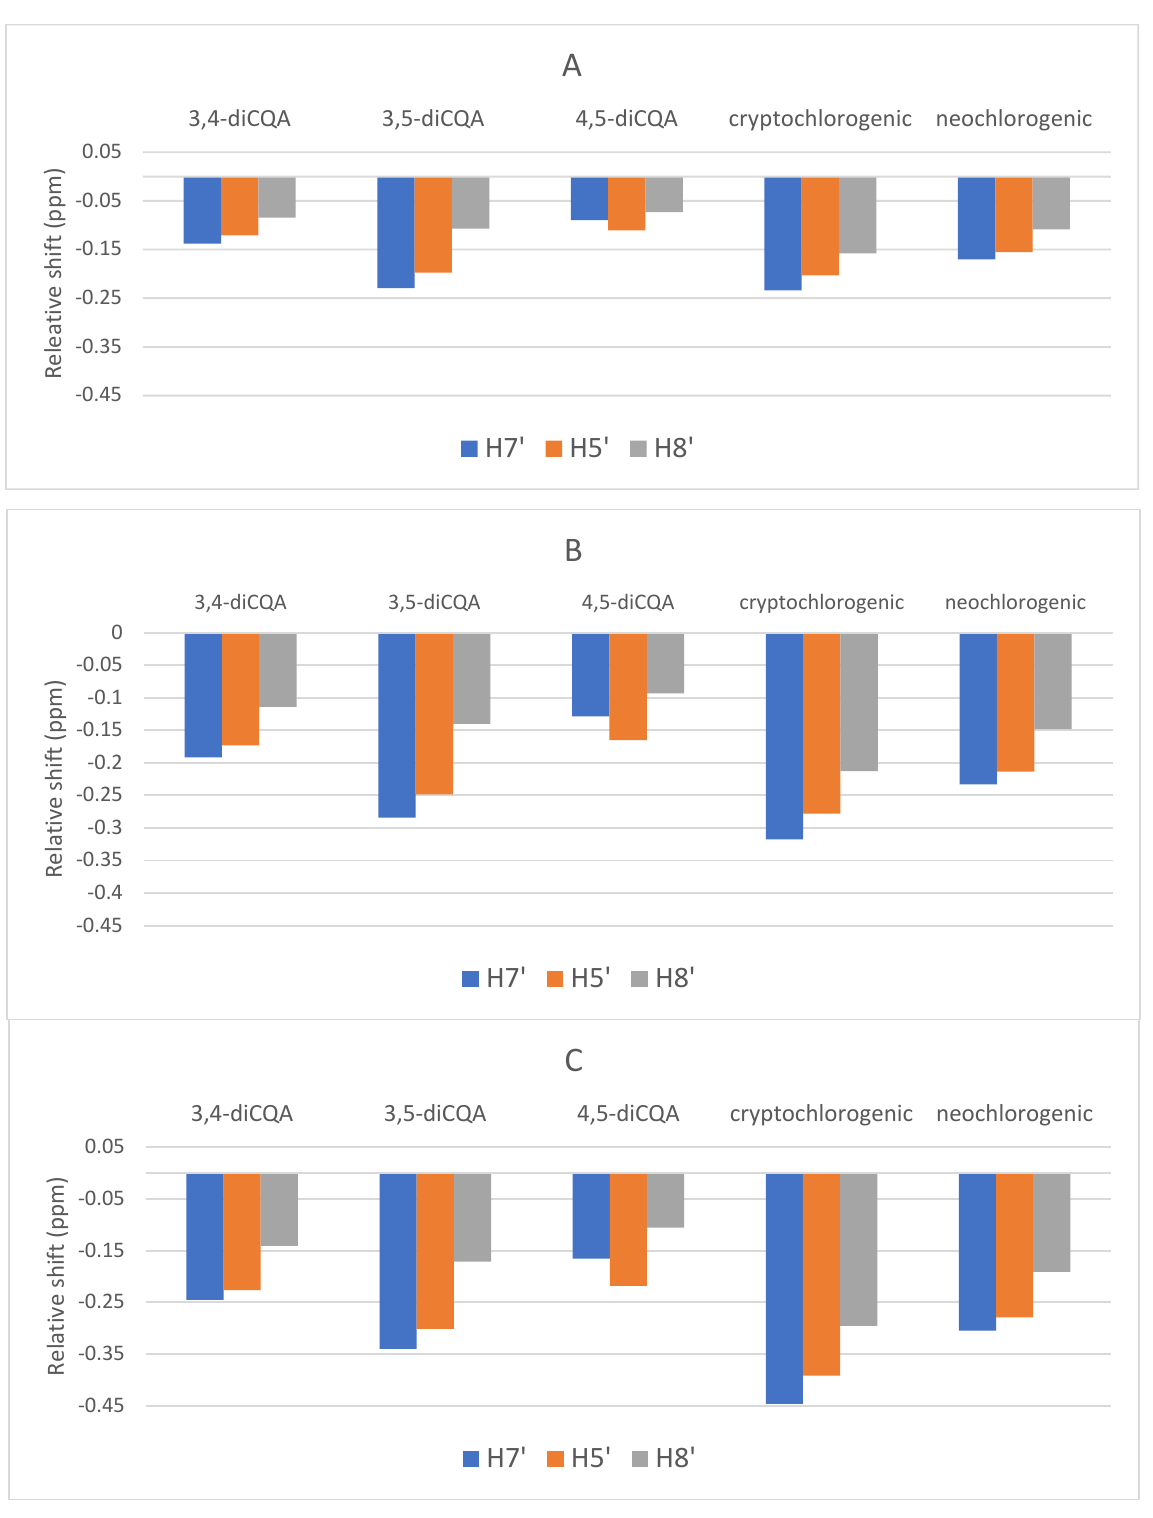
Figure 7. Relative complexation shifts of caffeine 1 H NMR signals with sequential addition of pure caffeine to CQA isomers: ( A ) caffeine (9 mM) and chlorogenic acids (3–10 mM) ( B ) caffeine (27 mM) and chlorogenic acids (3–10 mM) ( C ) caffeine (45 mM) and chlorogenic acids (3–10 mM).